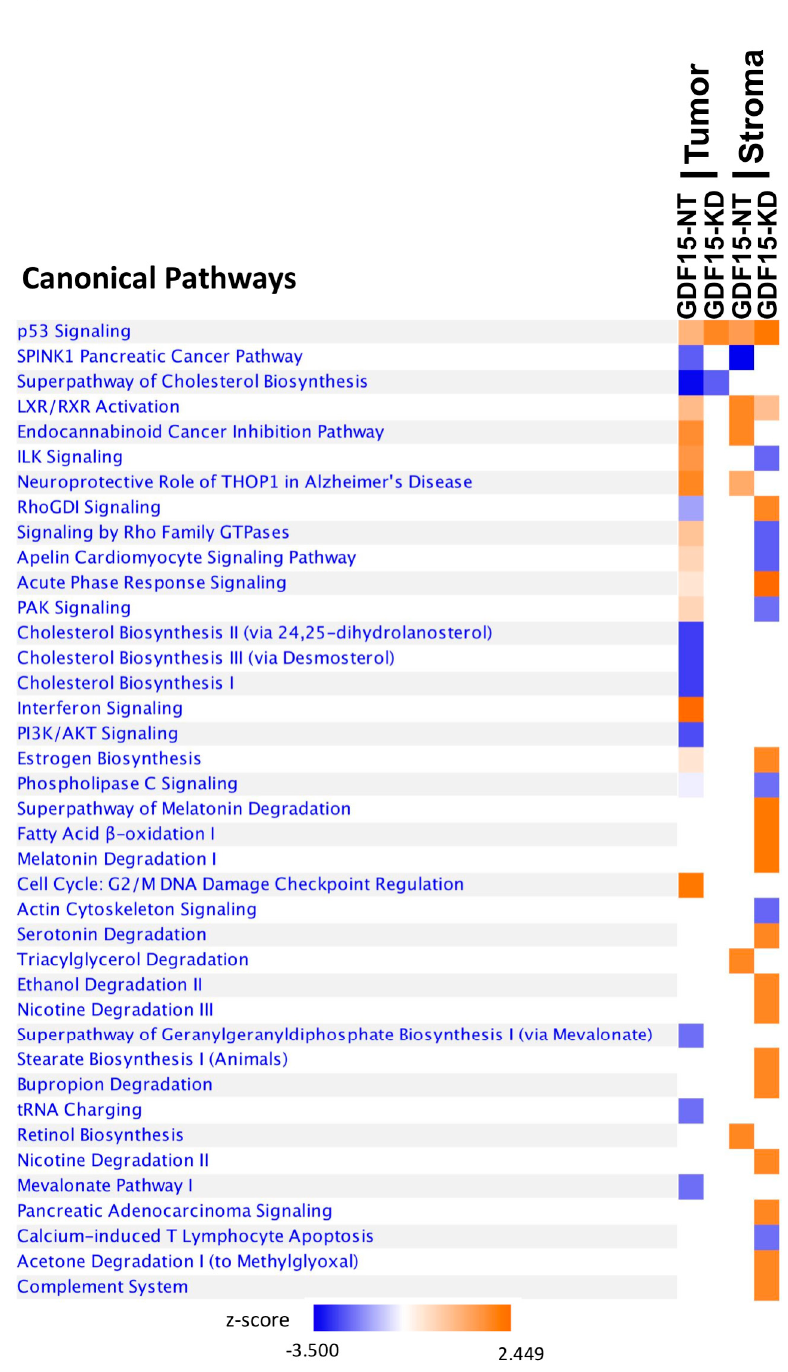
Figure 6. Activation or inhibition of canonical pathways in the tumor cell and stromal cell components of tumors formed by A2780 GDF15-NT control cells or A2780 GDF15-KD cells by cisplatin treatment. Z-score is a statistical measure of the match between expected relationship direction and observed gene expression changes after cisplatin treatment. z-score > 2 (activation) or z-score < 2 (inhibition) are considered significant.